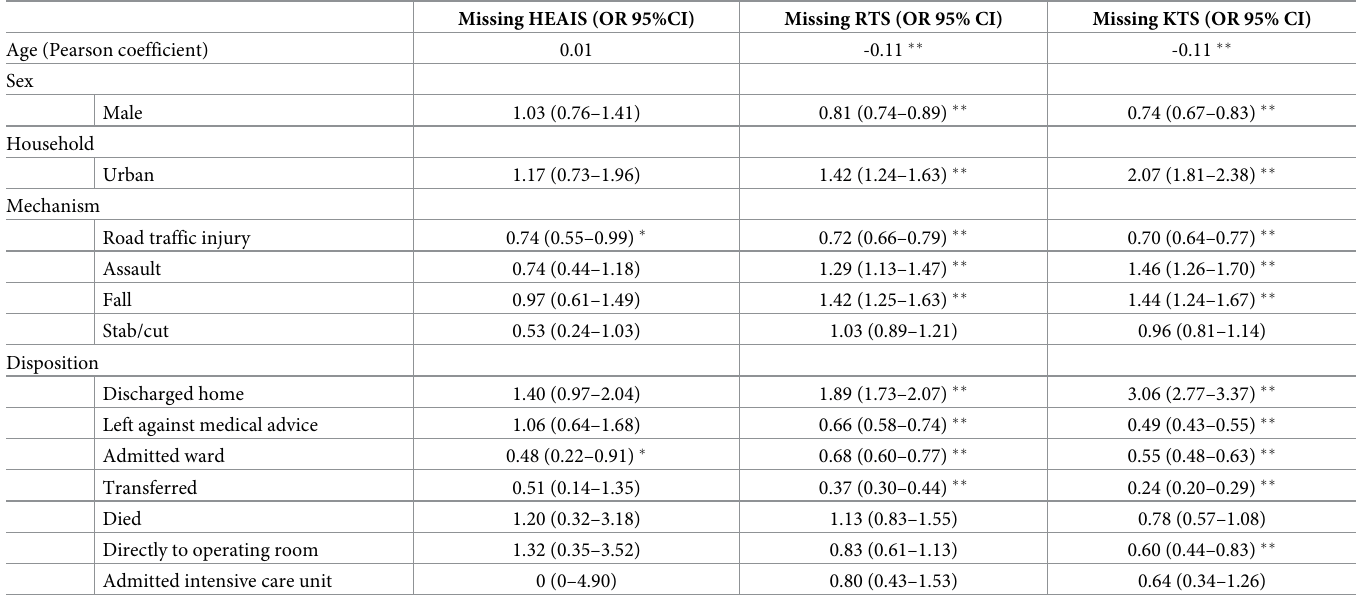
Table 4. Patient demographics, injury characteristics, and outcomes by HEAIS, RTS, and KTS data